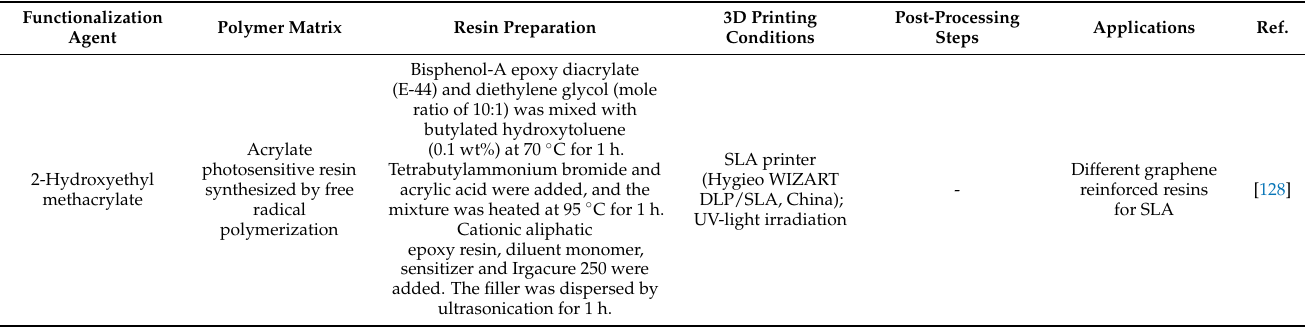
Table 3. The most representative 3D-printed functionalized graphene-based